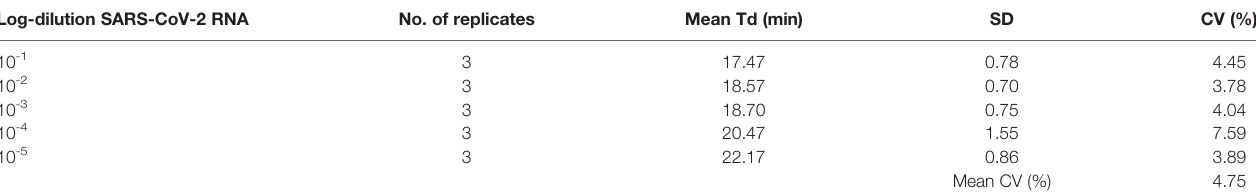
TABLE 2 | Intra-assay precision of the multiplex RT-LAMP assay. Log-dilution SARS-CoV-2 RNA